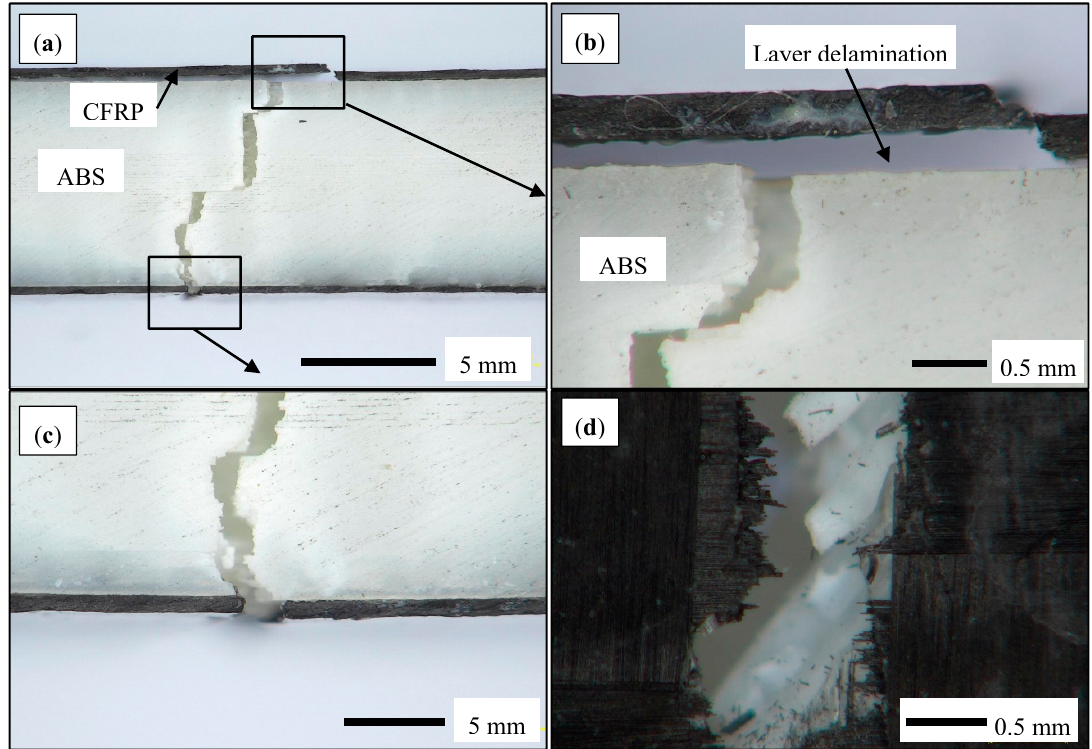
Figure 7. Optical microscopy images of the fractured tensile CFRP/ABS/CFRP sandwich samples: ( a ) side view of the broken sample; ( b ) top CFRP layer; ( c ) bottom CFRP layer; and ( d ) top view of the broken sample.